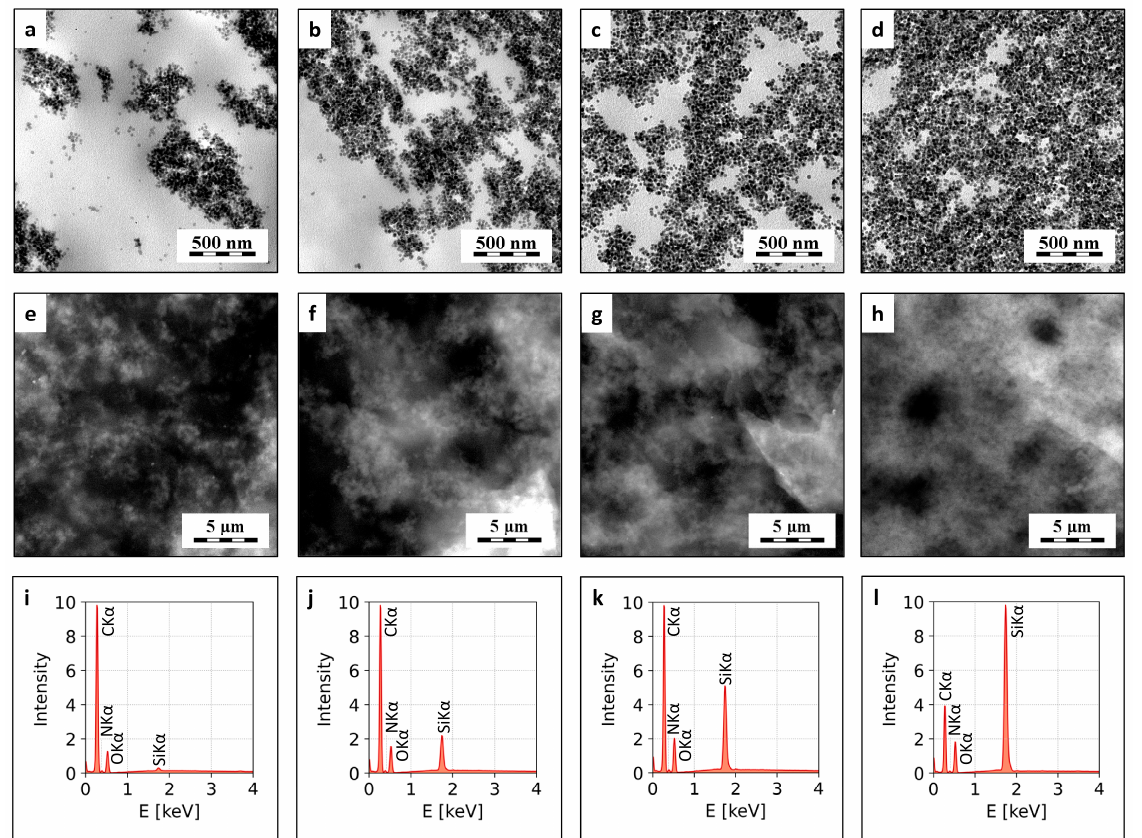
Figure 1. Morphology of PUU/nanosilica composites: ( a – d ) TEM/BF micrographs, ( e – h ) SEM/BSE micrographs, and ( i – l ) SEM/EDX spectra. The columns (from left to right) show the composites with 5%, 10%, 20%, and 40% of silica.